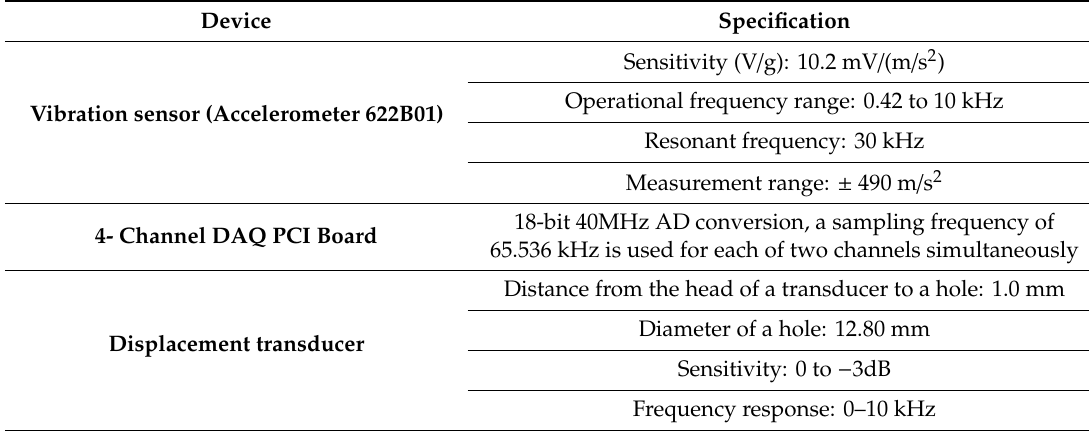
Table 1. Specification of the sensors and data acquisition system.